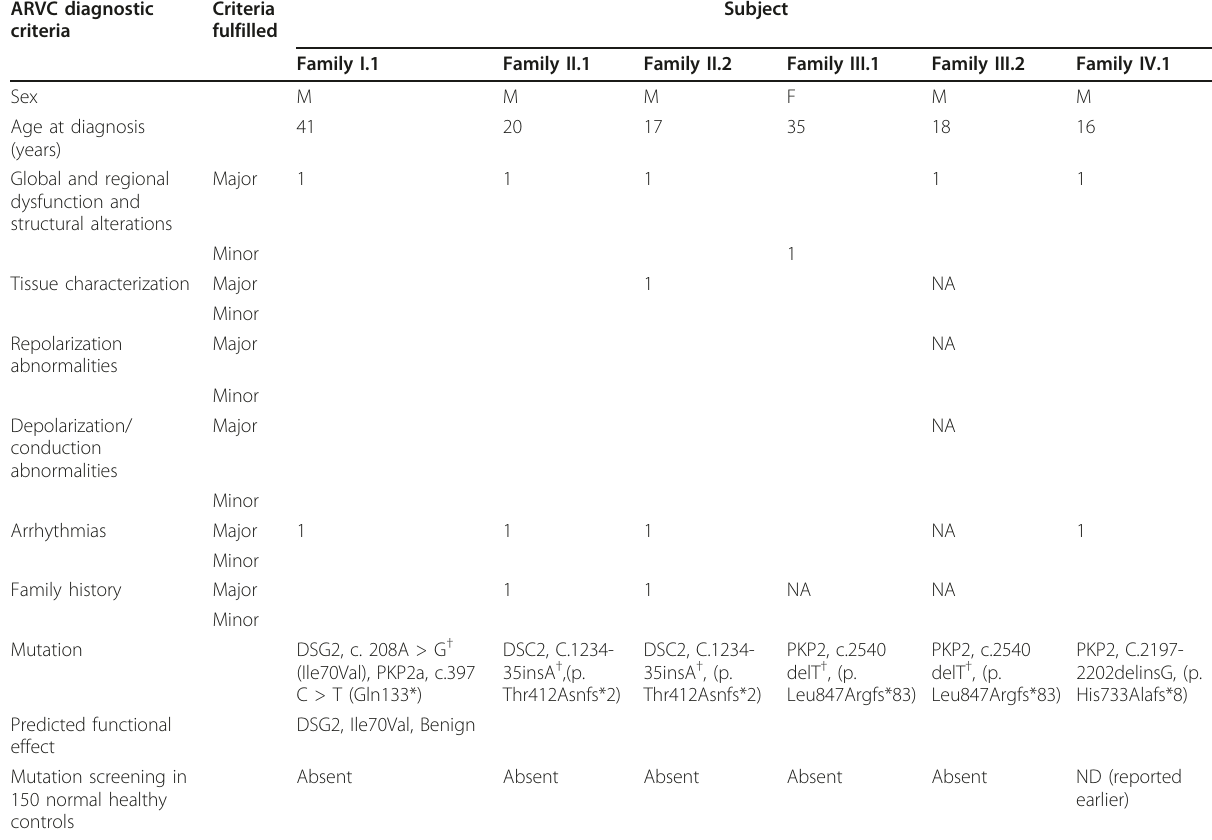
Table 1 Clinical characteristics of ARVC subjects with mutations in desmosomal genes ARVC diagnostic